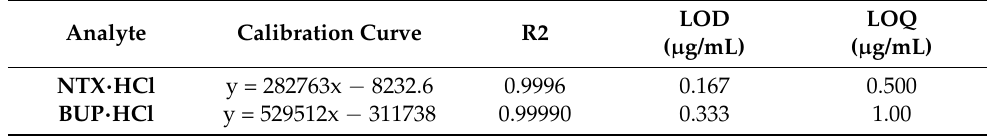
Table 4. Regression analysis, LOD and LOQ values.